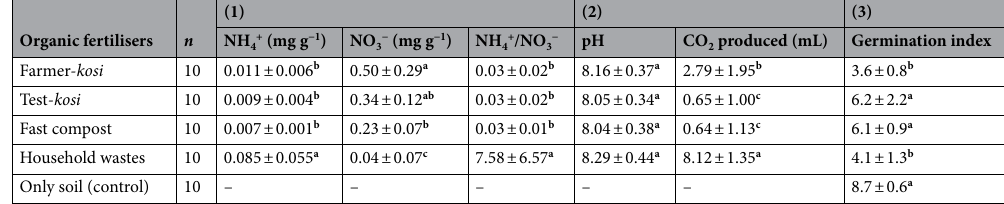
Table 2. (1) NH 4 + and NO 3 − concentrations and NH 4 + :NO 3 − ratios; (2) pH and CO 2 produced; and (3) garden cress germination index. Different superscript letters indicate statistically significant differences between the organic fertilisers and control ( P <